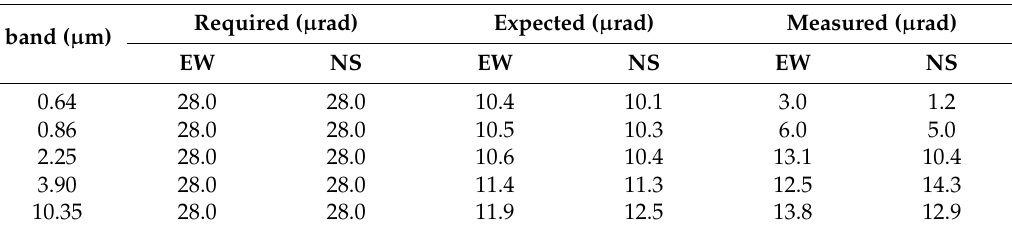
Table 4. Required, pre-launch estimate (expected), and on-orbit validation of channel navigation errors for GOES-16 ABI. The error is bias plus three standard deviations. EW is East–West direction, NS is North–South direction. INR performance is for the 99.73rd percentile over 24 h (data from the Calibration Working Group,